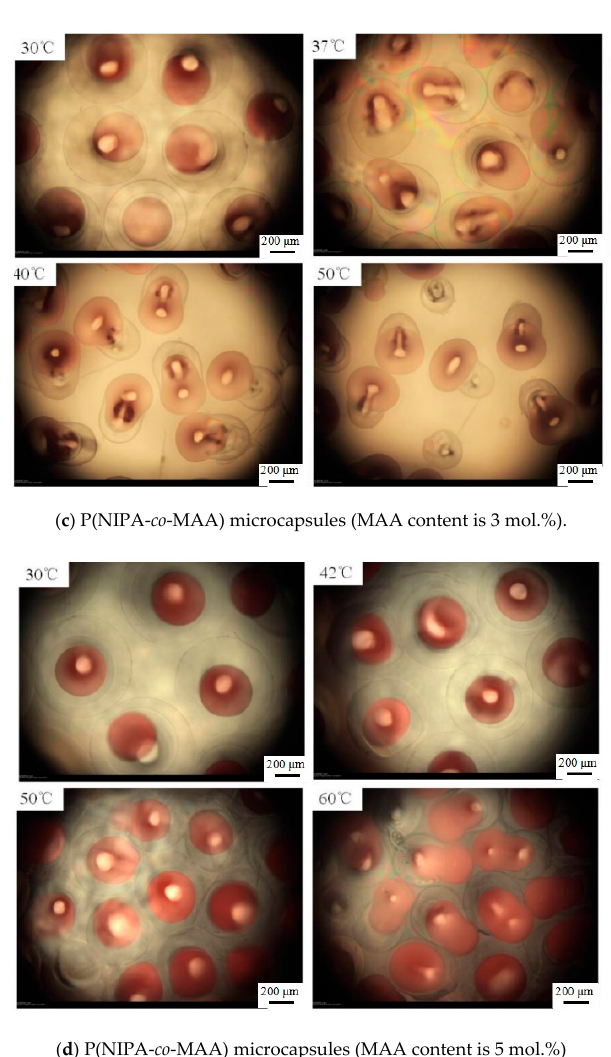
Figure 6. Optical microscopy photographs of release behaviors of P(NIPA- co -MAA) microcapsules with different MAA contents in aqueous solution at different temperatures. The scale bar is 200 μ m.